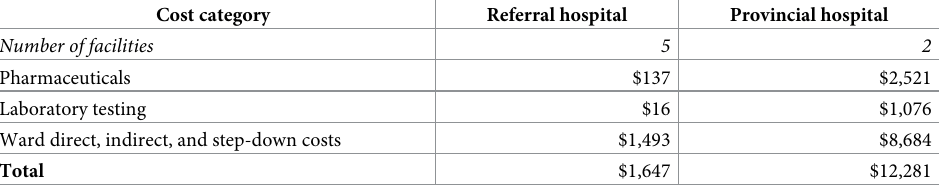
Table 8. Total costs for inpatient care for opportunistic infections per year, average by type of